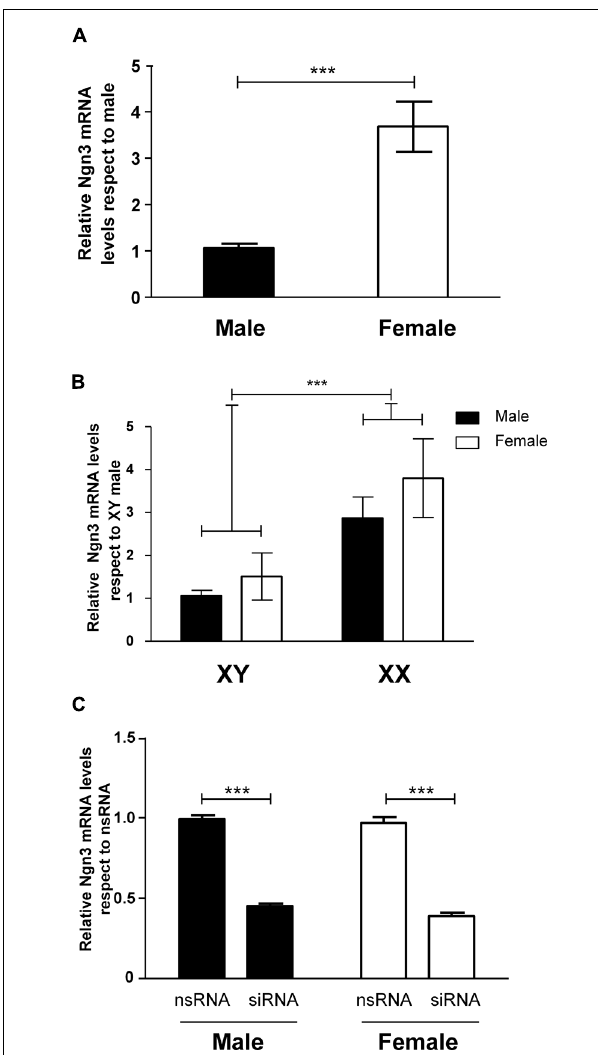
FIGURE 4 | Sex differences in the expression of Ngn3 in primary hypothalamic neurons. (A) Ngn3 mRNA levels in male and female hypothalamic neurons at 3 DIV. (B) Ngn3 mRNA levels in the four core genotype model. (C) Validation of siRNA targeting Ngn3 (siRNA) and a control non-targeting siRNA (nsRNA) in male and female hypothalamic cultures. Data are mean ± SEM. n = 6–9 independent cultures for each sex and treatment. LSD test indicated significant differences *** p <